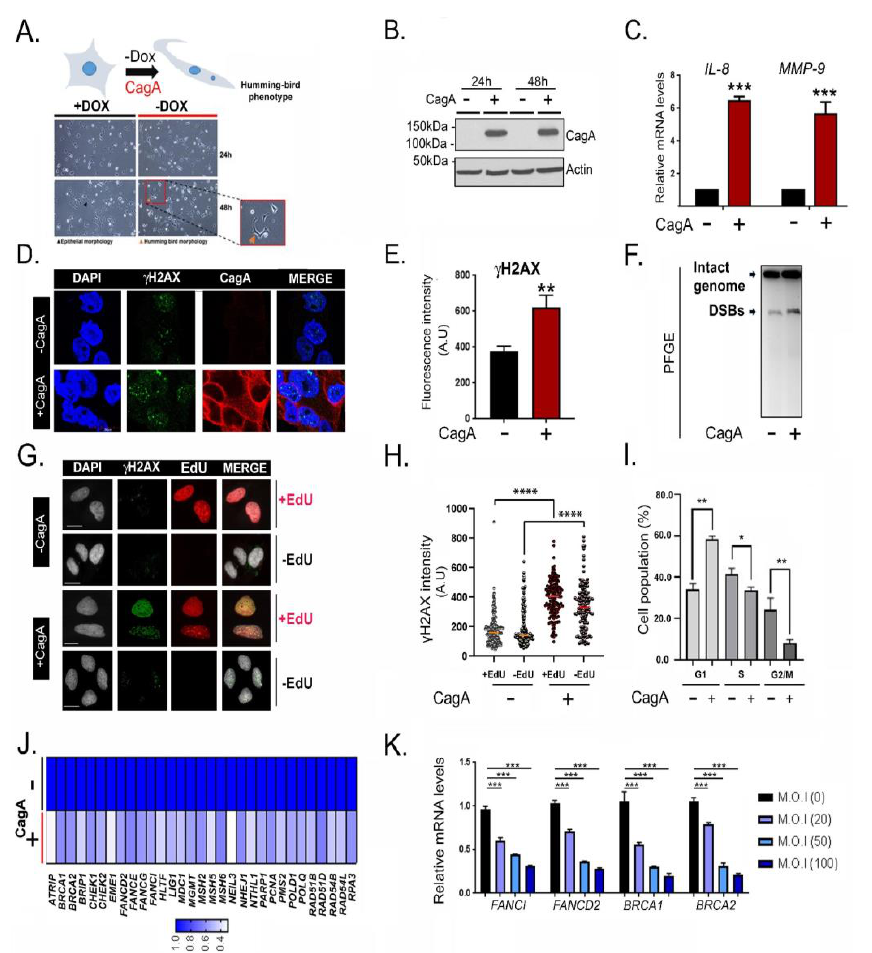
Figure 1. The H. pylori oncoprotein CagA induces host DSBs and downregulates FA repair factors. ( A ) Dox-inducible MKN28 − CagA cells were either left untreated ( − CagA) or subjected to doxycycline withdrawal (+CagA) for 24 h or 48 h as indicated. Representative images displaying hummingbird morphology in CagA-expressing cells (cartoon-inset); scale bar = 100 µ M. ( B ) Immunoblot indicating the expression of HA-tagged CagA at two different time points following doxycycline withdrawal (24 and 48 h). Western blots were probed with anti-HA antibody . ( C ) Q-PCR for IL-8 and MMP9 was performed 48 h following doxycycline withdrawal. ( D ) Representative immunofluorescence images stained for DAPI, HA, and γ H2AX. ( E ) Quantification of nuclear γ H2AX fluorescence in the presence or absence of CagA using the operetta high-high content imaging system (methods). ( F ) Pulsed- Field Gel Electrophoresis image showing DNA DSBs in CagA-expressing cells . ( G ) Representative immunofluorescence images showing EdU labelling using click-IT reaction and γ H2AX staining in the presence and absence of CagA expression. ( H ) Quantification of nuclear γ H2AX and EdU in the presence and absence of CagA. A total of at least 200 cells were analysed per experimental condition with three biological replicates n = 3. ( I ) MKN28 cells were cultured in presence or absence of Dox for 48 hrs. Cells were then stained with propidium iodide and were subjected to cell cycle analysis using flow cytometry. Percentages of cells in G1 and S and G2 phases are shown. The experiments were performed in triplicate. ( J ). Dox-inducible MKN28 − CagA cells were left untreated ( − CagA) or subjected to doxycycline withdrawal (+CagA) for 72 h following by RNA-seq analysis. Heatmap showing the status of 31 downregulated DNA repair genes upon CagA expression. ( K ) . MKN28 cells were infected with wild-type H. pylori for 24 h at the indicated multiplicity of infection (M.O.I). Samples were harvested for Q-PCR analysis and the normalized expression levels of FANCI, FANCD2 , BRCA1 , and BRCA2 are shown (n = 3). Student’s t -test was performed for statistical analysis. Graphs show mean ± SD. Asterisks represent significant differences. * p < 0.05; ** p < 0.01; *** p < 0.001; **** p <